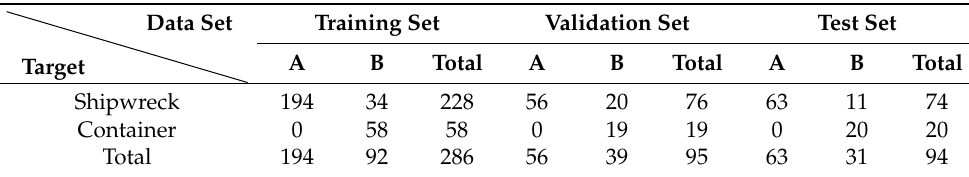
Table 1. The training set, the validation set and the test set.